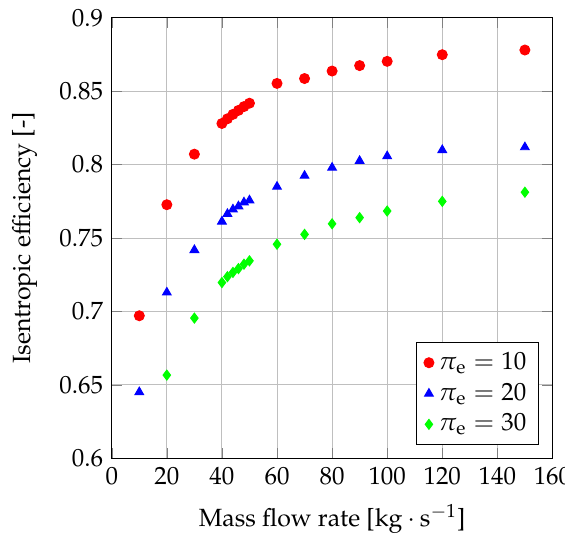
Figure 6. Surrogate turbine model at fixed rotational speed, relating total-to-total isentropic efficiency to the mass flow rate and pressure ratio across the turbine.